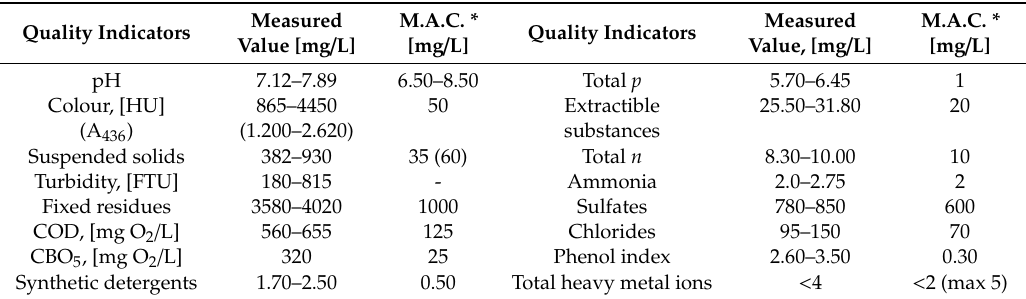
Table 1. The principal characteristics of the studied textile